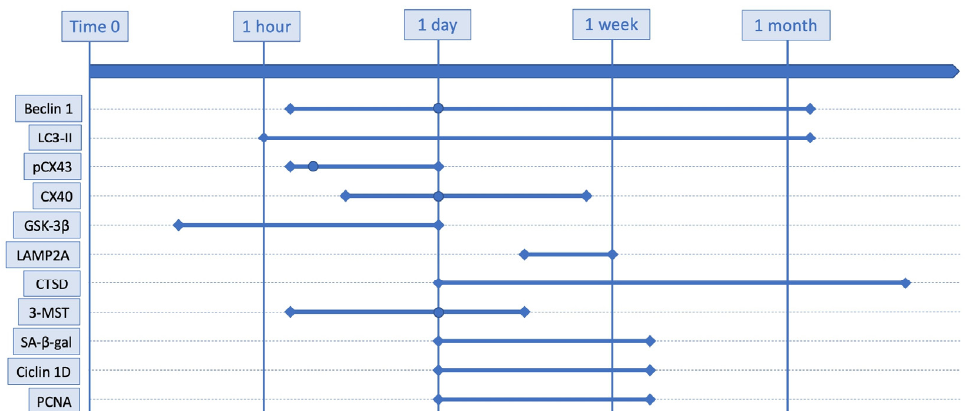
Figure 1. Schematic representation of main markers for which this study identifies a consensus of elevation after TBI, in TBI models with various techniques. Round dots indicate the peak of increase when known. Table 2. Summary of markers and major findings for each one of them.